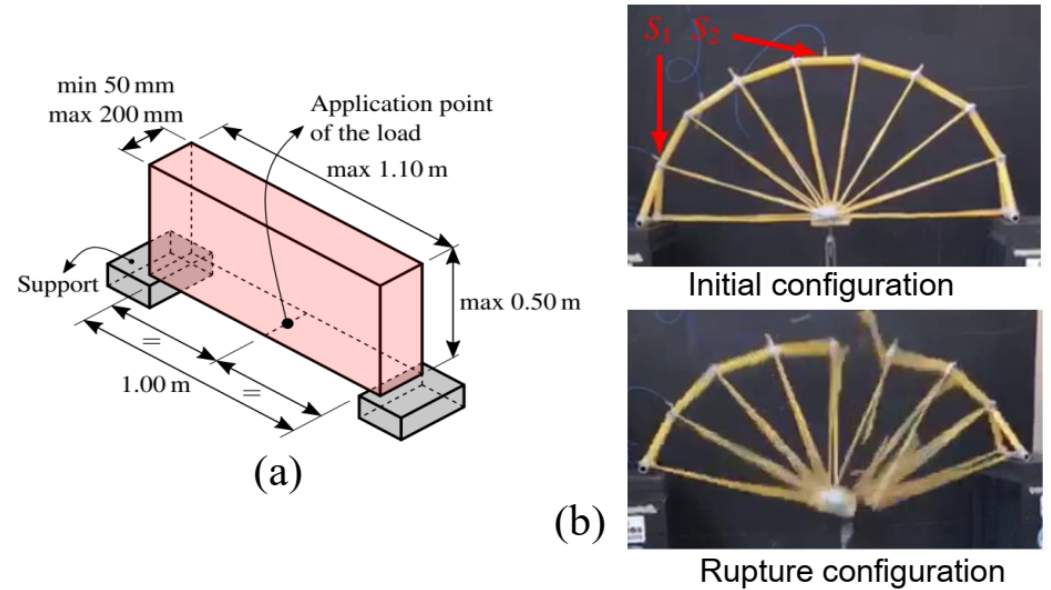
Figure 13. “Spaghetti” Bridge Model: ( a ) Geometric restrictions for the contest, ( b ) The initial and